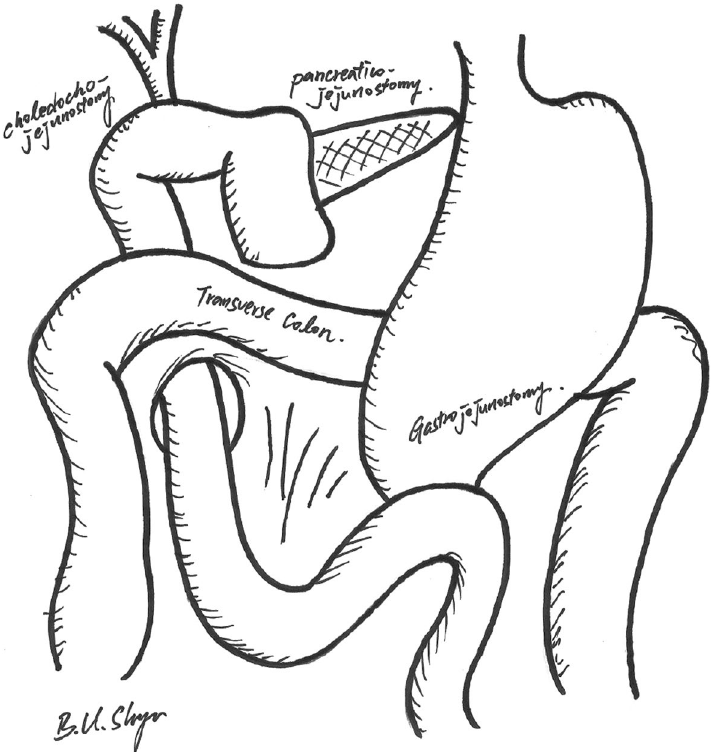
Figure 1. Sketch illustration of surgical technique in RPD with antecolic, antiperistaltic, and inframesocolic gastrojejunostomy. The influence of inflammation created after pancreaticoduodenal resection or related to the pancreatic fistula on the gastrojejunal anastomosis could be avoided or